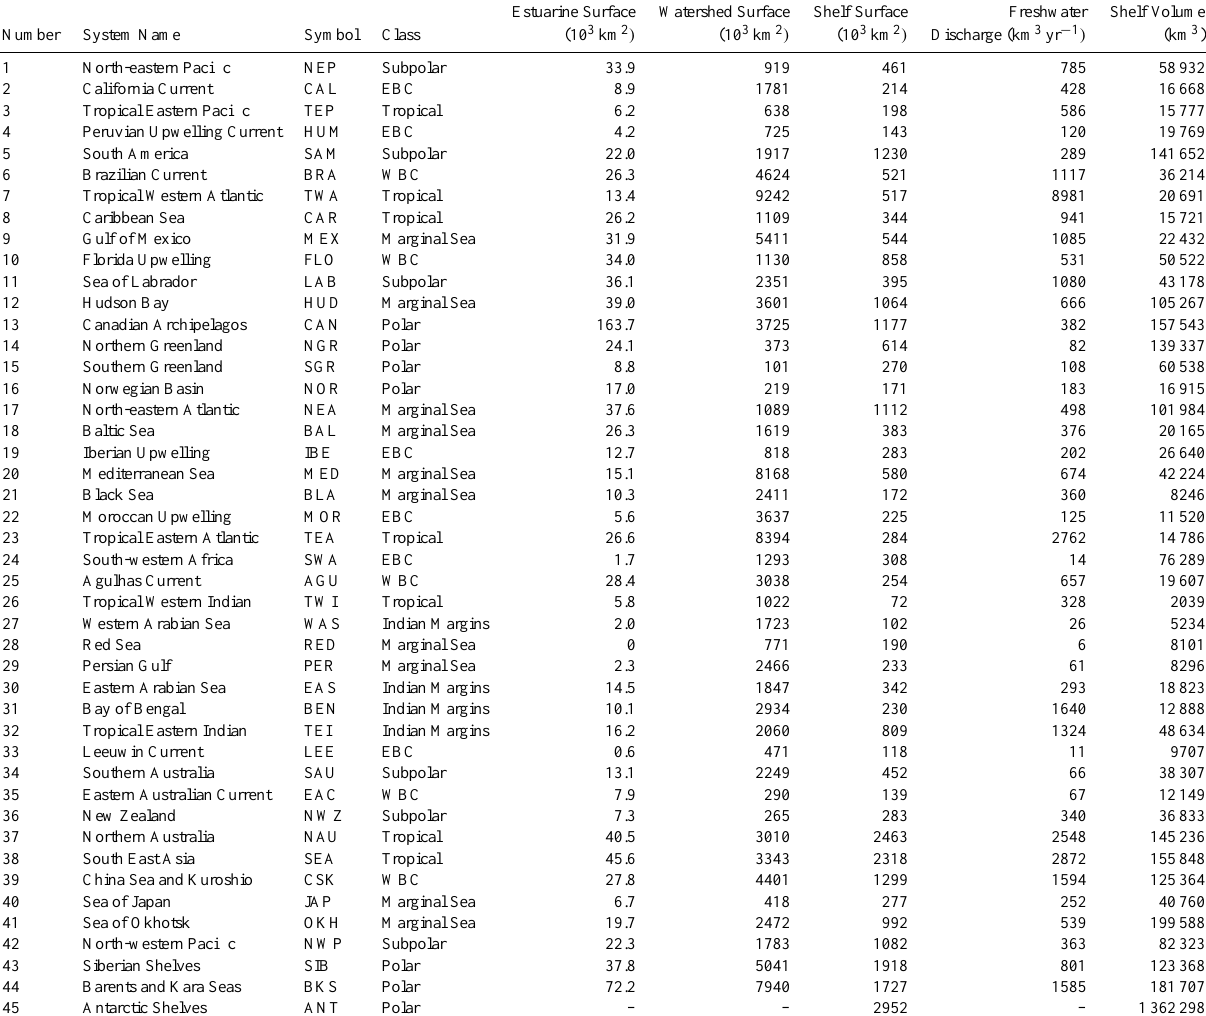
Table 3. List of the MARCATS segments with their type, the surface area of their various components, the freshwater discharge and the volume of their continental